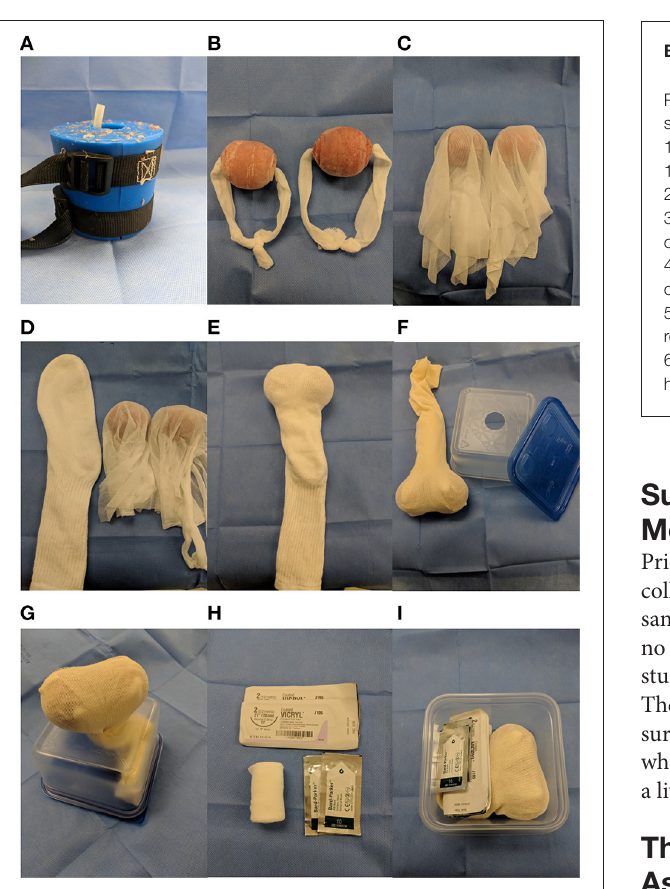
FIGURE 2 | Overview of making and assembling components of low-fidelity equine castration model. Mold used to pour silicone testicles with rubber tubing to create a hole in the center (A) . Silicone testicles threaded with 18 inch length of 2 inch conforming stretch gauze bandage material to serve as the spermatic cord (B) . Testicles draped with stretchable mesh fabric (cut in 15 inch diameter circles) to represent the vaginal tunic (C) . Large men’s tube sock containing side-by-side testicles (D,E) . Upside-down 42 ounce re-usable food container with open-end of tube sock inserted through 1.25 inch hole (F,G) . Suture and blades included as part of castration model kit (H) . All components assembled for distribution to students (I)